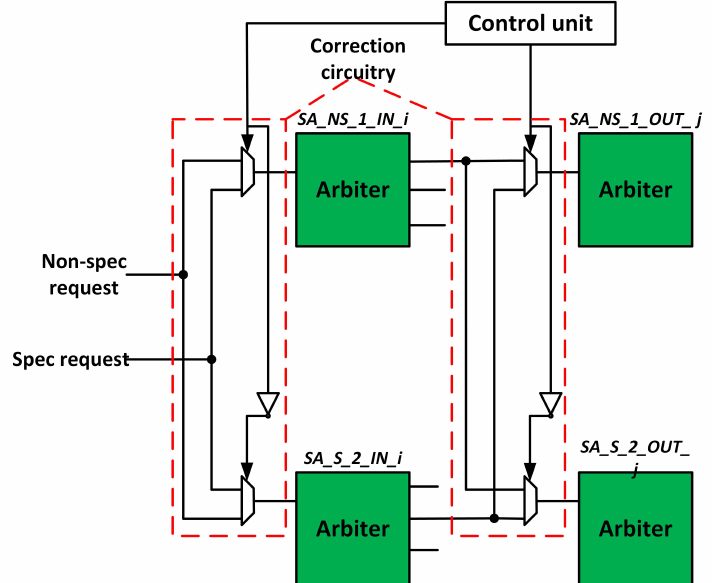
Figure 9. Switch allocation (SA) fault-tolerant